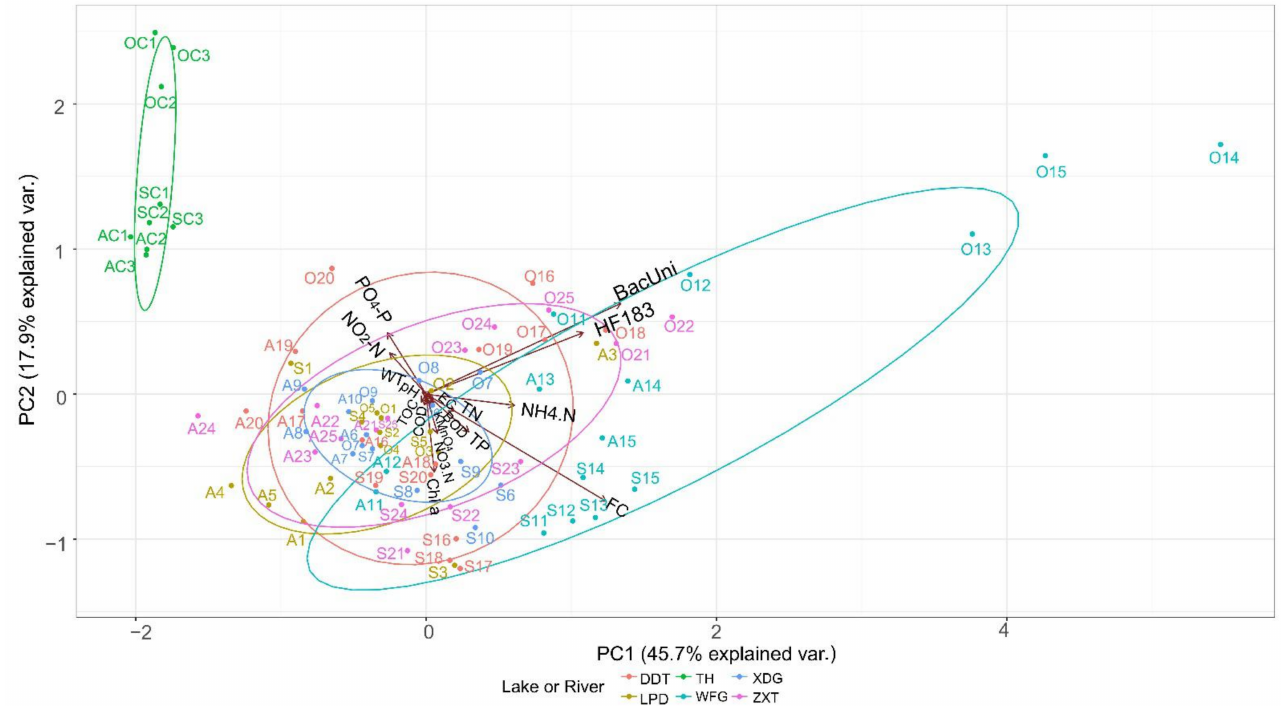
Figure 9. The principal component analysis (PCA) of physicochemical and microbiological variables observed in this study. The labels indicate both sampling locations and sampling time. The locations are indicated by the numbers (1–25 for rivers/lake, C1–C3 for control locations), while the sampling time are indicated by the first letter (A = August, S = September, O = October). Each lake or river is grouped by the circle and marked with different colors. Length of the respective arrow shows the proportion a factor explains for the total